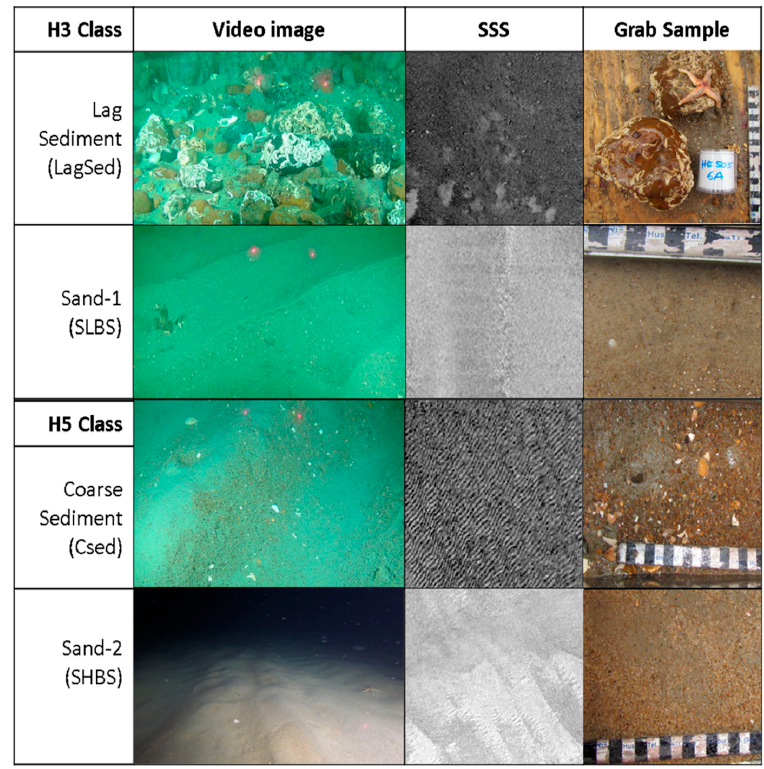
Figure 2. Sediment classes in H3 and H5 that were identified based on sediment and video samples (NB: laser spacing = 10 cm). The pixel resolution of the side-scan data is 0.25 m. Abbreviations: SLBS,